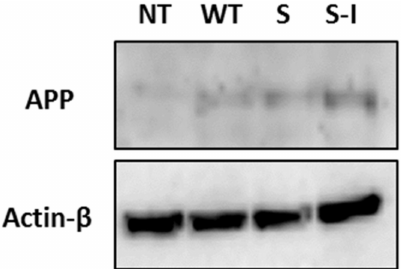
Figure 2. Establishing a stably transfected FAD cell-model system. A representative Western blot (WB) indicating APP overexpression in stably transfected SK-N-SH cells. Expression of APP695 in cells overexpressing wild type (APP WT ), Swedish (APP S ), or Swedish-Indiana (APP S-I ) compared to the non-transfected cells (NT). Actin-b was used as a loading control. Table 1. Viable cell concentration normalised against initial value for n = 3. Student t-test analysis revealed a significant difference between the 0 h and 24 h stress induction in all three cell lines. p < 0.05 for APP WT and APP S and p < 0.01 for APP S-I .